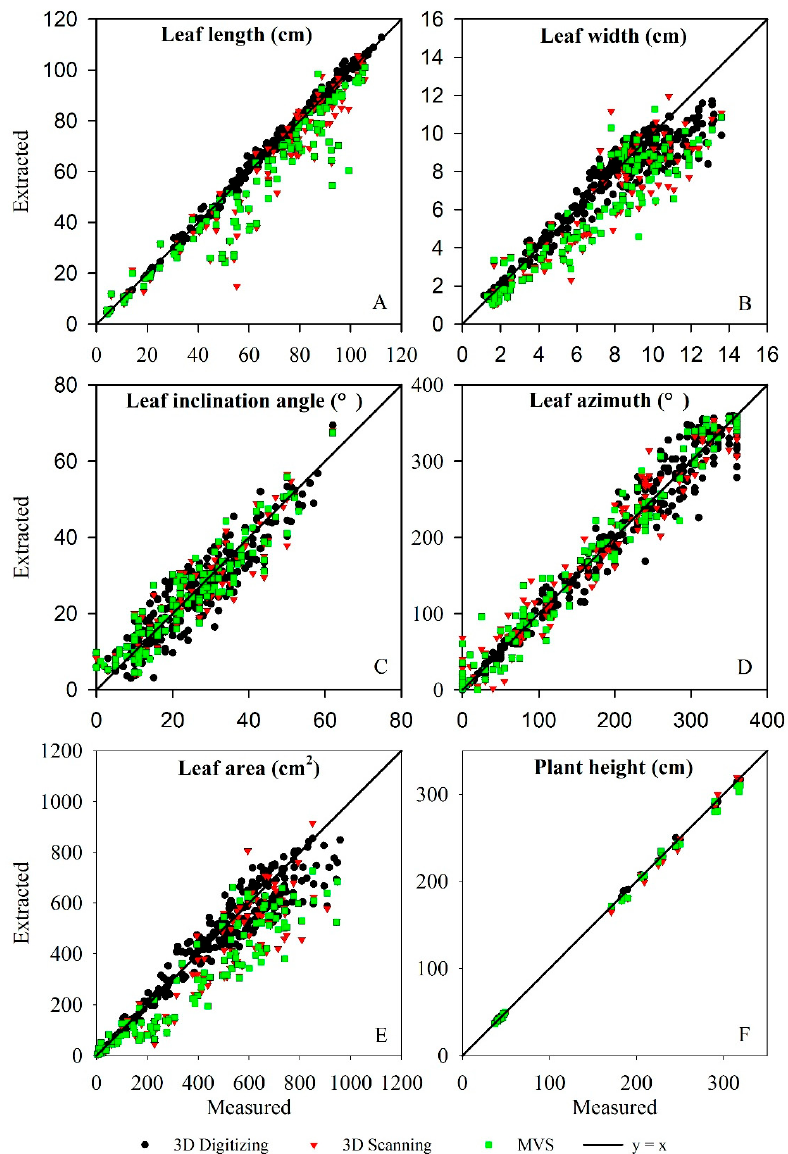
Figure 7. Phenotyping parameter evaluation derived by 3D scanning, MVS reconstruction, 3D digitizing, and manual measurement. The samples used contain all three hybrid plants in three growth stages. Evaluated parameters include ( A ) leaf length, ( B ) leaf width, ( C ) leaf inclination angle, ( D ) leaf azimuth, ( E ) leaf area, and ( F ) plant